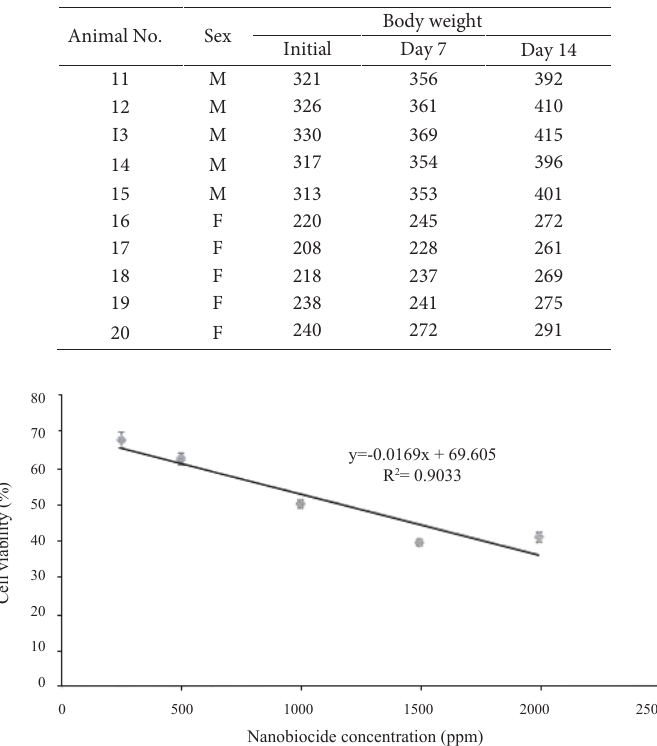
Fig 2. MTT cell viability assay, cytotoxicity induced in Nanobiocide® treated human lymphocyte